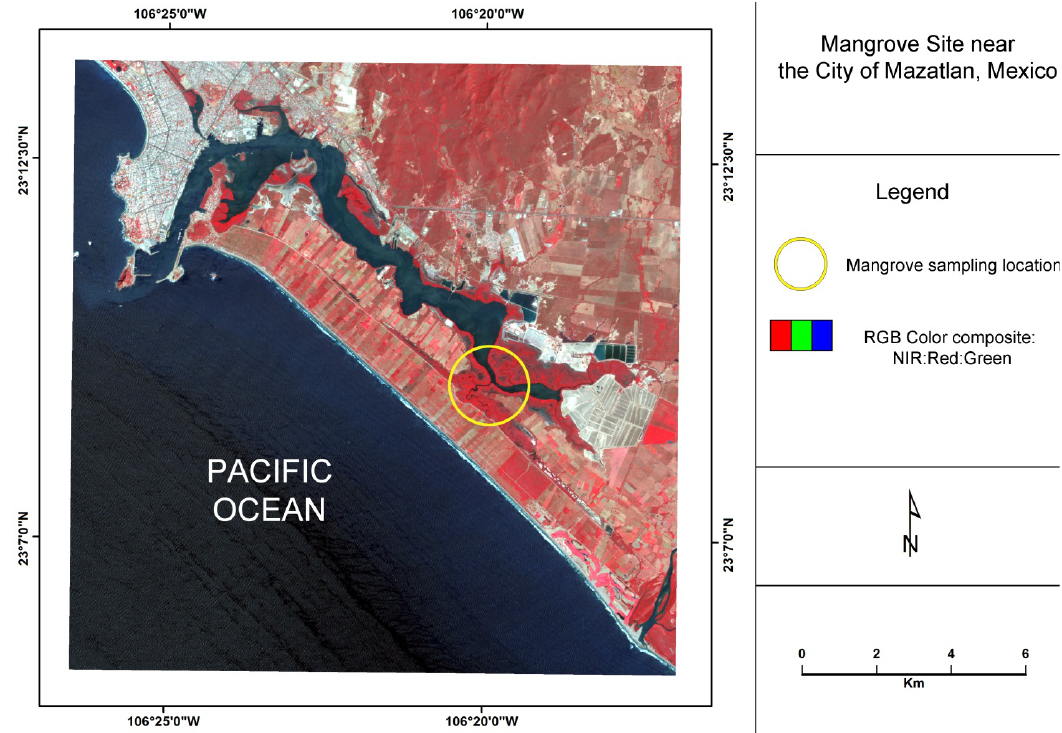
Figure 1. Location of the mangrove sampling area within the Mexican Pacific (Enhanced Near Infrared, Red, Green of Advanced Land Observing Satellite date Advanced Visible and Near Infrared Radiometer (ALOS AVNIR)-2 dated 28 March